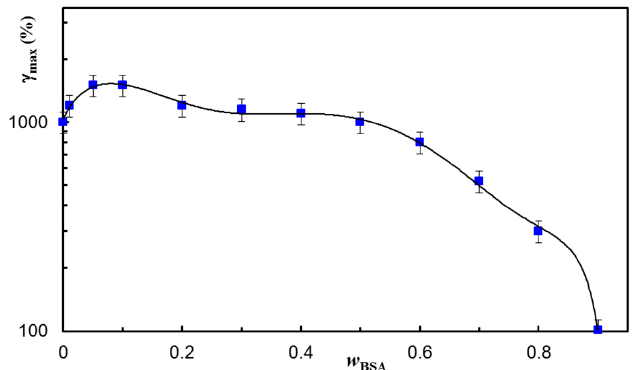
Figure 8. The maximum value supported by hydrogels of different compositions before the failure of their structure. The continuous line is a guide to the eye.